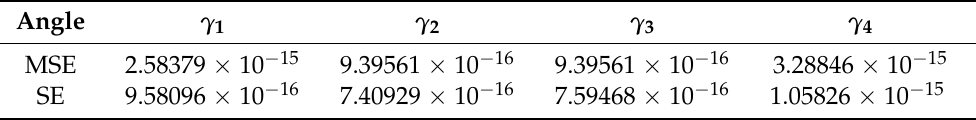
Table 9. Mean Squared Error (MSE) and Standard Error (SE) of inverse kinematics.